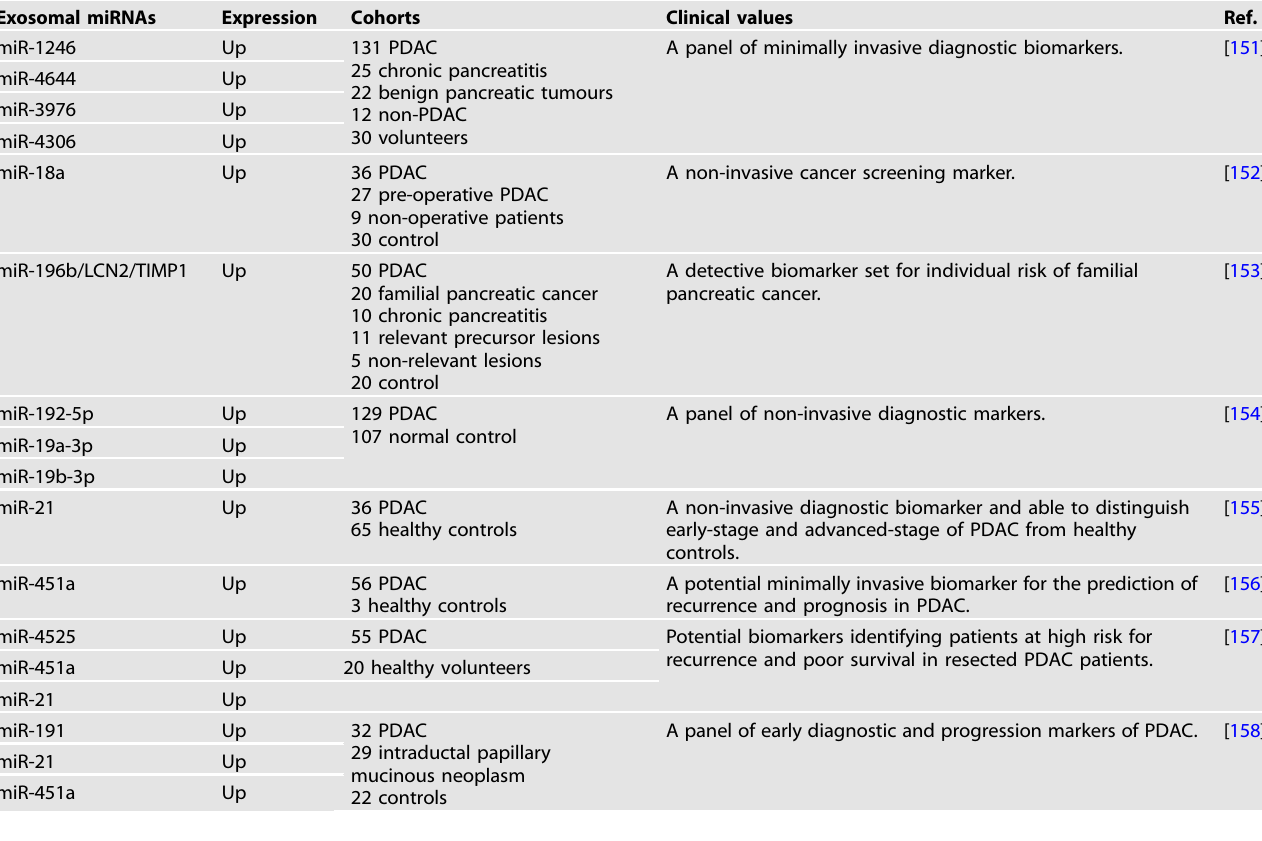
Table 2. Outline of PDAC-derived circulating exosomal miRNAs and clinical values. Exosomal miRNAs